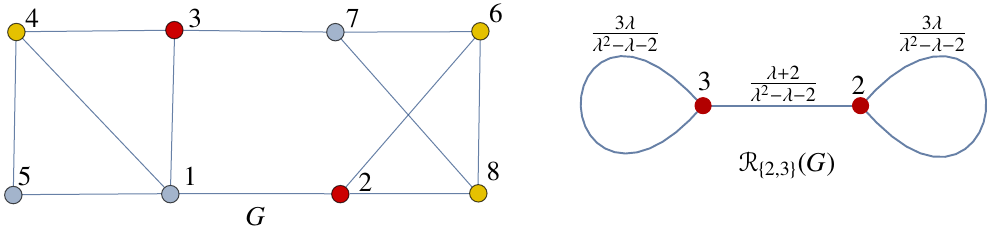
Fig. 3 (Left) The undirected graph G from Figure 2 which has both standard and latent symmetries. Red vertices 2 and 3 are latently symmetric. Yellow vertices 6 and 8 have a standard symmetry between them, but 4 is latently symmetric to both of 6 and 8. (Right) The isospectral reduction of the top graph over vertices 2 and 3, showing the latent symmetry between these two